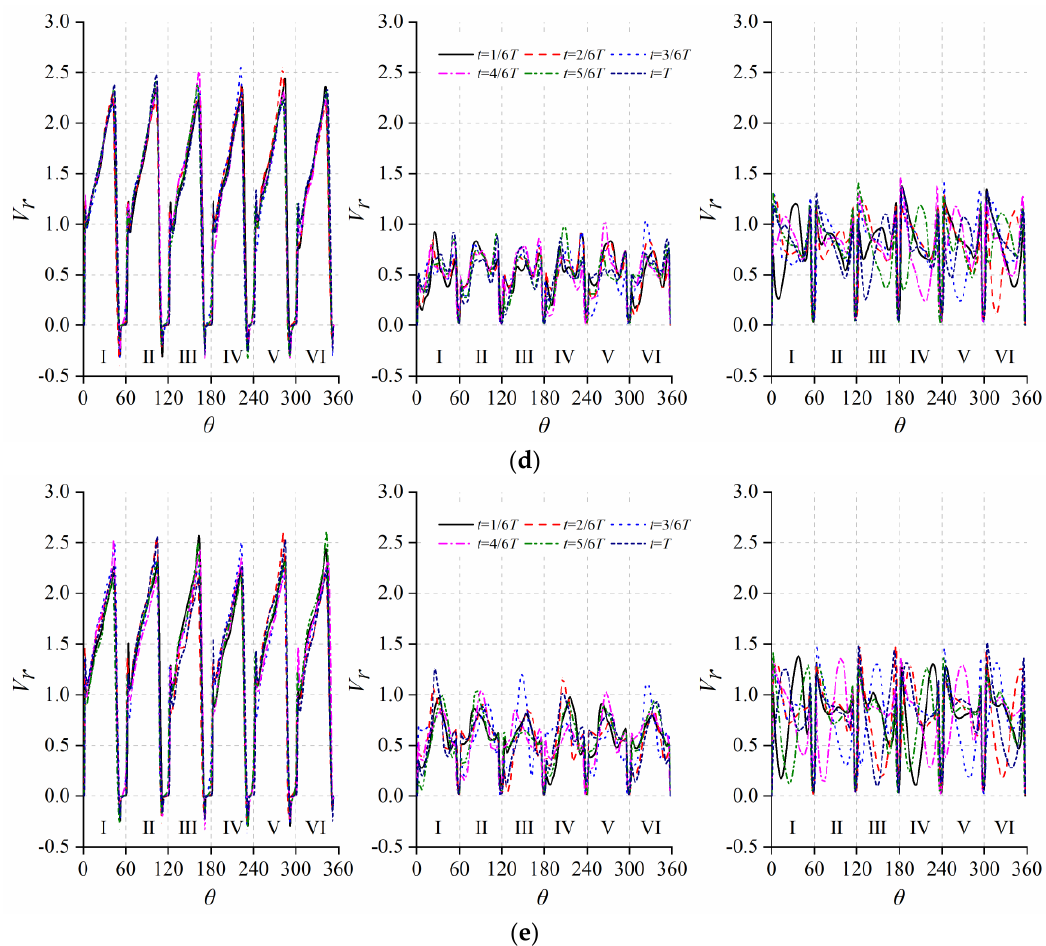
Figure 7. ( a – e ) Distributions of instantaneous normalized radial velocity along the circumferential direction at r* = 0.0 (left), r* = 0.5 (middle) and r* = 1.0 (right) for (from top to bottom) U rot /U ref = −0.5, −0.3, 0.0, 0.3 and 0.5.